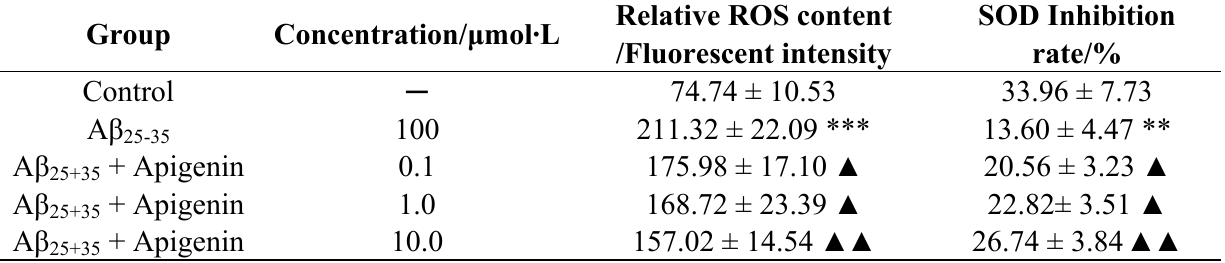
Table 2. Effects of apigenin on intracellular ROS level and SOD activity against A β -induced 25–35